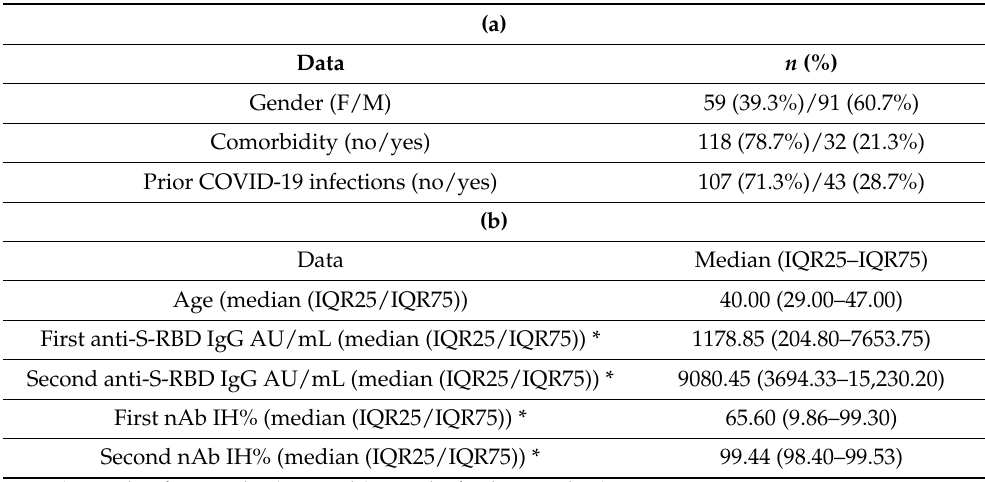
Table 1. (a) Distribution of demographic data of all participants. (b) Distribution of age and laboratory data of all participants (median